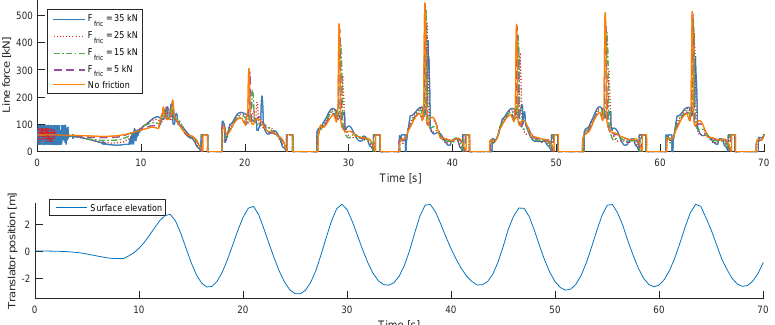
Figure 8. The force in the connection line when the WEC is impacted by a high regular wave. Five levels of friction are